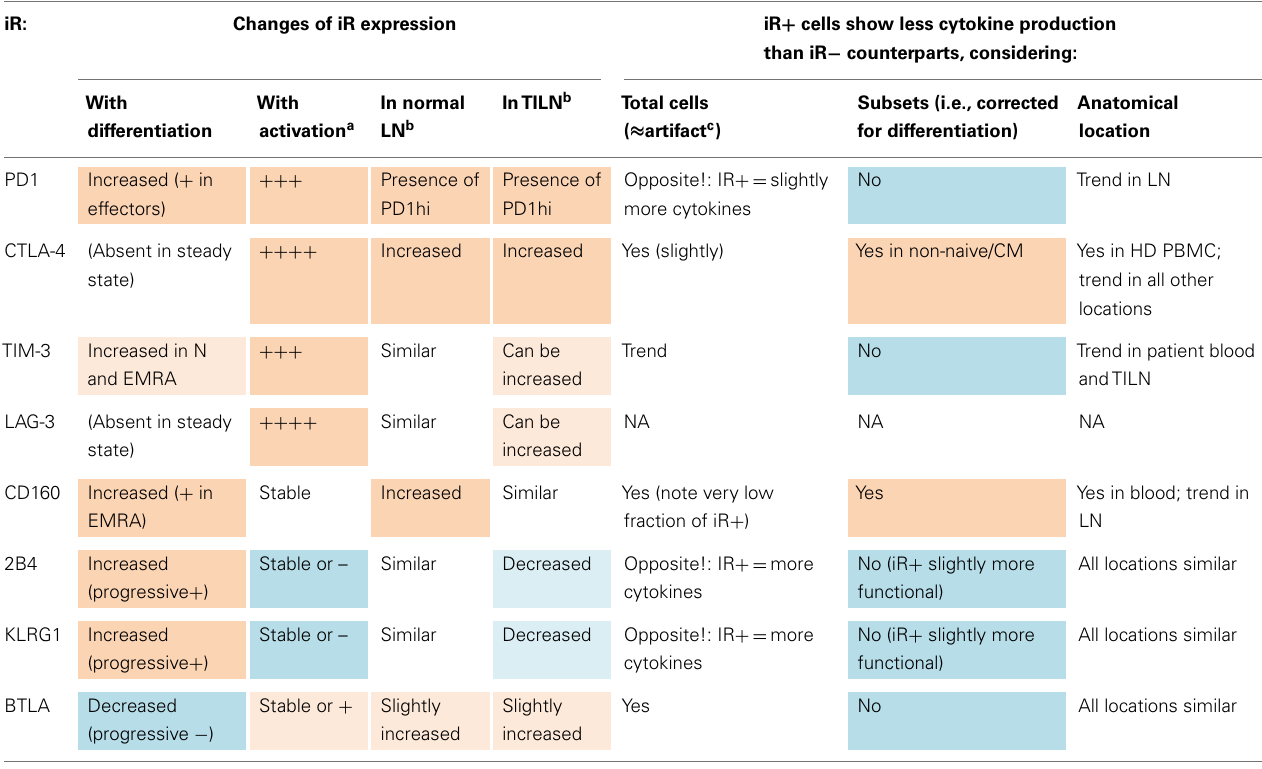
patient, and non-metastatic LN, and two distinct examples are shown for TILN. Naïve cells are shown in white histograms and non-naïve cells in gray histograms. (B) . Quantification showing the percentage positive cells for each iR as well as for IFNg andTNFa amongst the indicated sample groups. p -Values were based on multiple comparisons using one-way ANOVA with Bonferroni correction. (C) . Analysis of the expression ofTNFa and IFNg in iR positive or negative cells, within non-naïve cells, amongst the indicated sample groups. Pie arcs and slices represent the percentage positive for IFNg and/orTNFa as indicated in the legend.